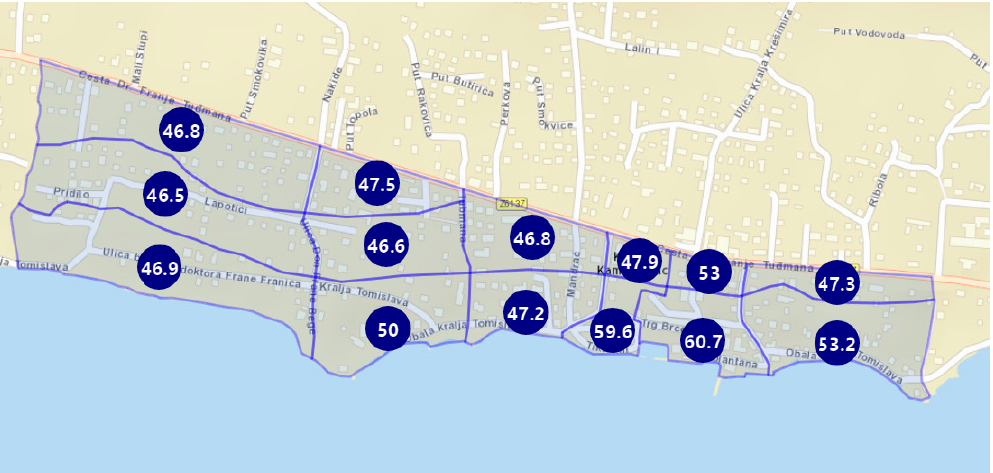
Figure 20. Results of the risk analysis for seismic, flood and extreme waves hazards for Level 1 (Scenario S-F-EW L1).